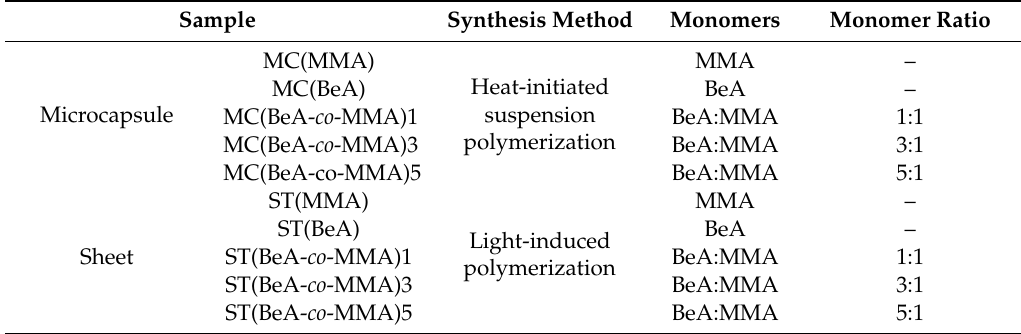
Table 1. Composition of all the thermal-energy-storage copolymer microcapsules and sheets with a crystalline n -behenyl side-chain synthesized in this work by varying monomer mass ratios. Sample Synthesis Method Monomers Monomer Ratio MMA – MC(MMA) Heat-initiated MC(BeA) BeA – suspension Microcapsule MC(BeA- co -MMA)1 BeA:MMA 1:1 polymerization MC(BeA- co -MMA)3 BeA:MMA 3:1 MC(BeA-co-MMA)5 BeA:MMA 5:1 ST(MMA) MMA – ST(BeA) BeA – Light-induced ST(BeA- co -MMA)1 BeA:MMA 1:1 Sheet polymerization ST(BeA- co -MMA)3 BeA:MMA 3:1 ST(BeA- co -MMA)5 BeA:MMA